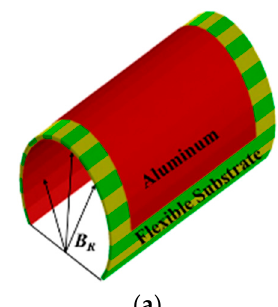
Figure 9. Bending Radius ( a ), Bending Scenarios ( b ).